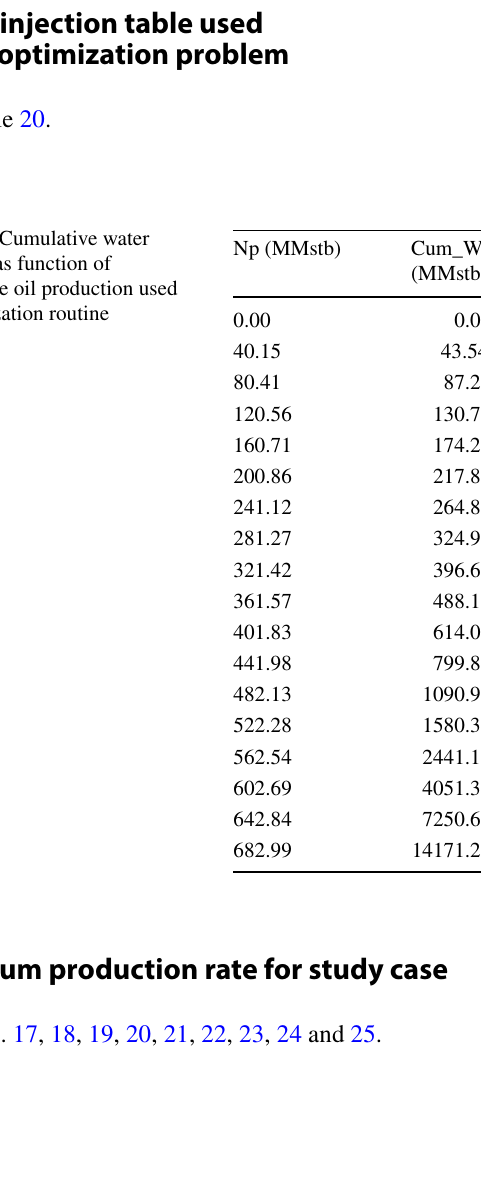
Fig. 20 Optimum oil production profile and oil production potential for strategy TLP with GL + WI